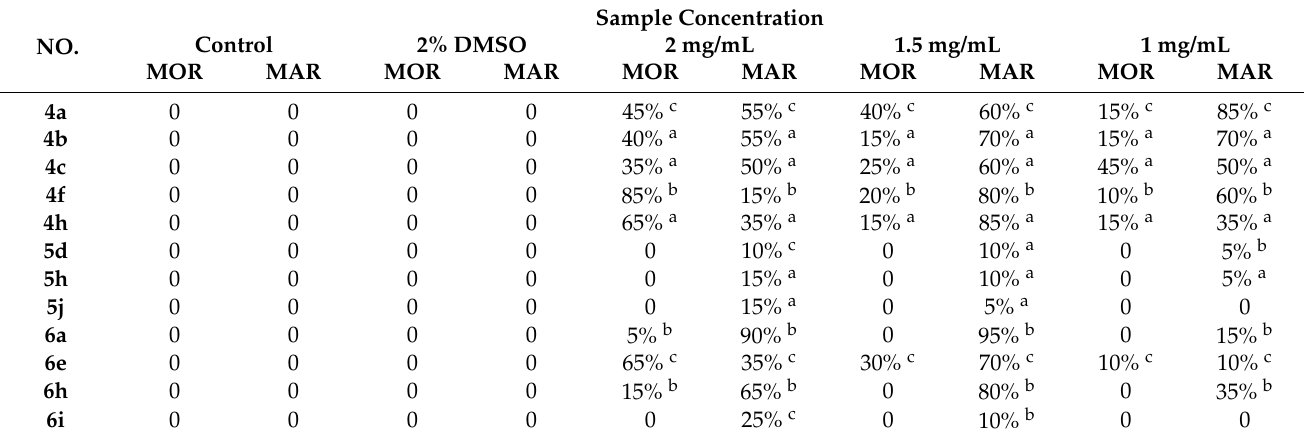
Table 2. The mortality rate (MOR) and malformation rate (MAR) of some of the selected compounds. Sample Concentration Control 2% DMSO 2 mg/mL 1.5 mg/mL 1 mg/mL NO.